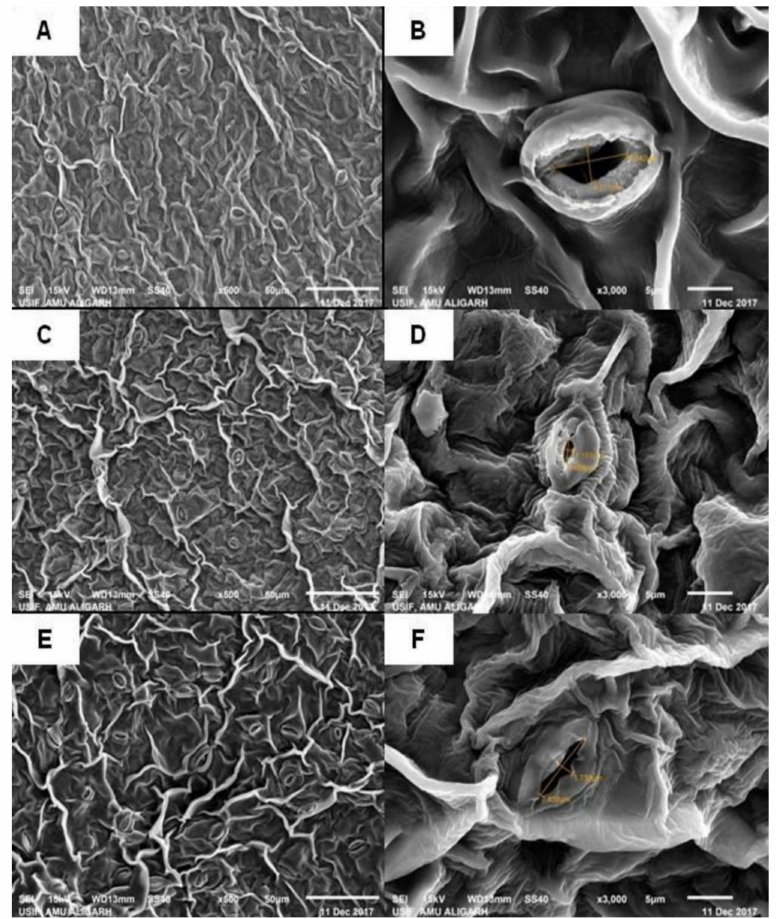
Figure 4. Stomatal behavior of mustard examined under ( A , B ) control, ( C , D ) 100 mM NaCl, and ( E , F ) ETH treatment with split doses of N and S with 100 mM NaCl. The stomatal response of opening and closing was viewed with SEM at 500 × ( A , C , E ) and 3000 × ( B , D , F ) magnification in mustard plants developed under 100 mM NaCl at 40 DAS. Bars ( A , C , E ) = 50 µ m; bars ( B , D , F ) = 5 µ